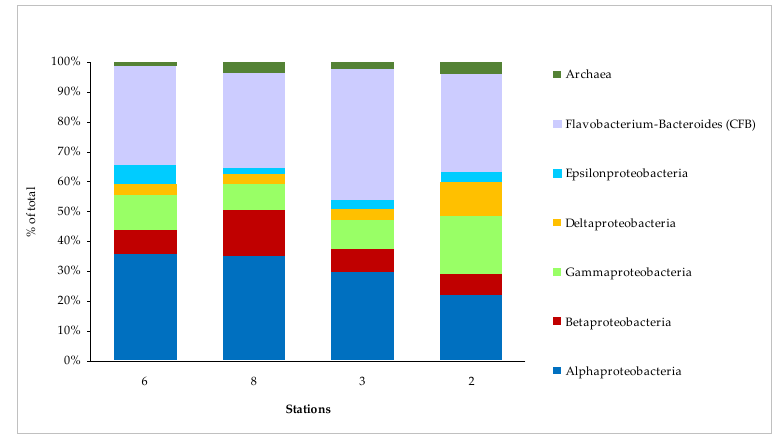
Figure 7. Percentage contribution of different taxa detected by CARD-FISH analysis.